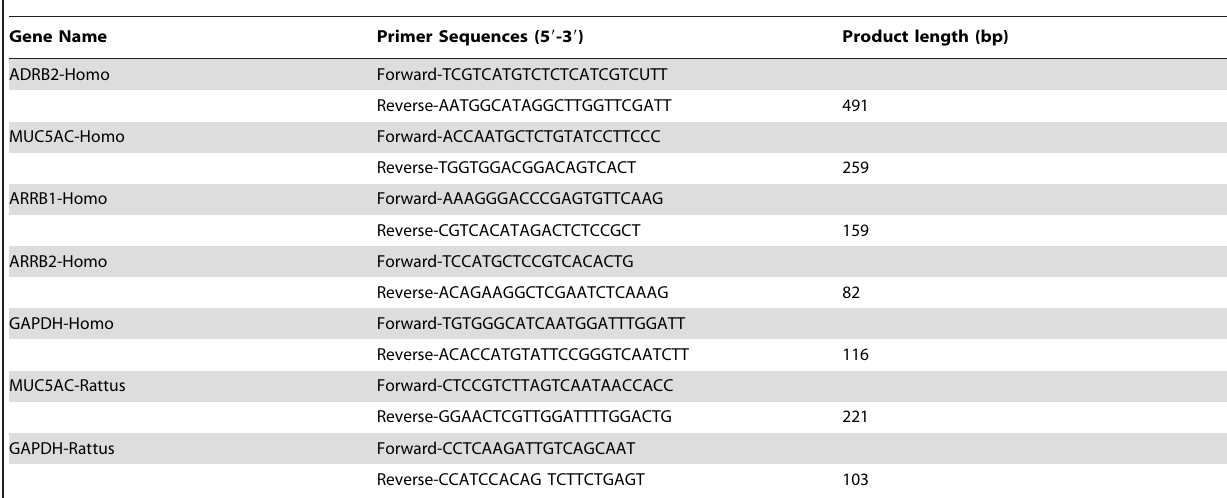
Table 2. Primer sequences used in experiments.